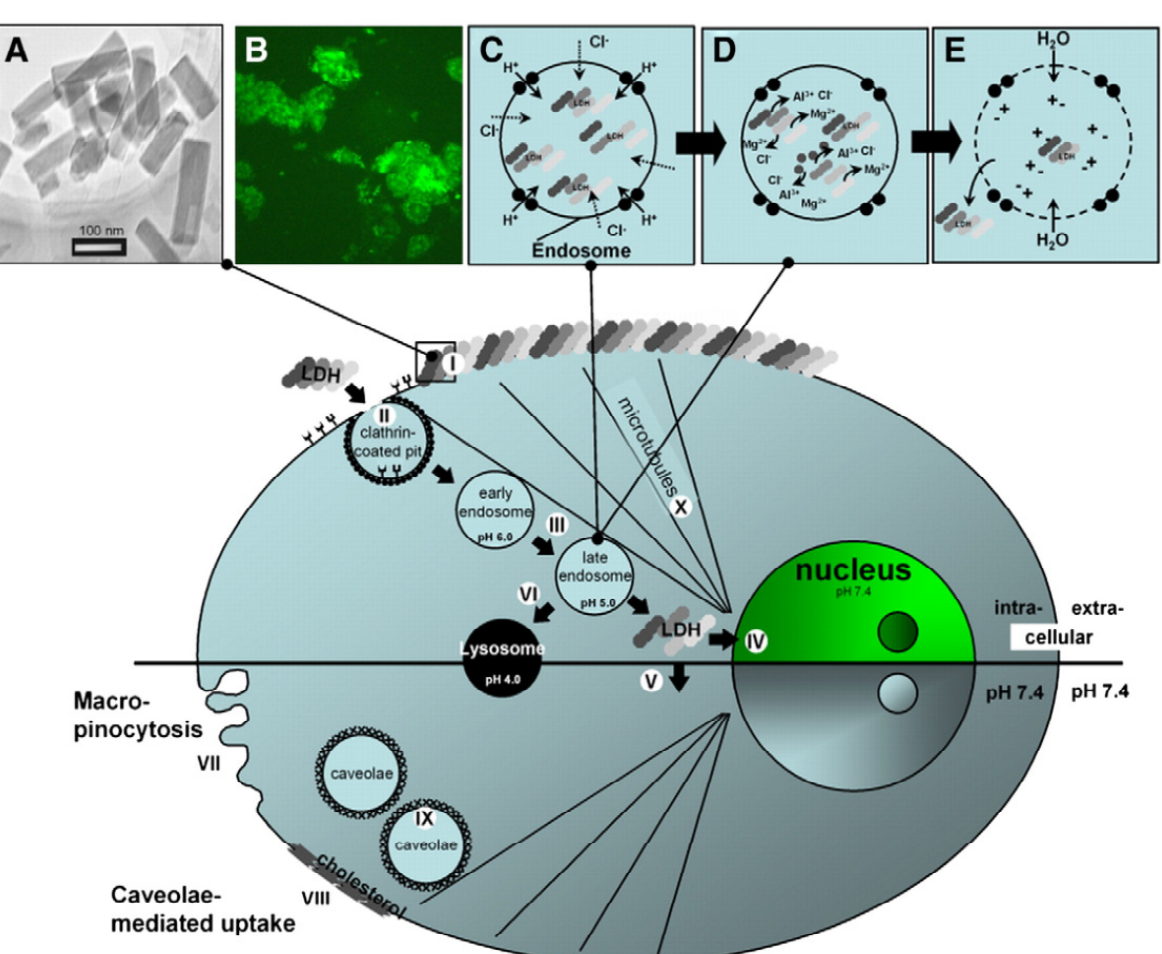
Figure 2. Schematic illustration of LDH-FITC nanoparticle intracellular fate. ( A ) TEM image of LDH-FITC nanoparticles; ( B ) CHO cells transfected with